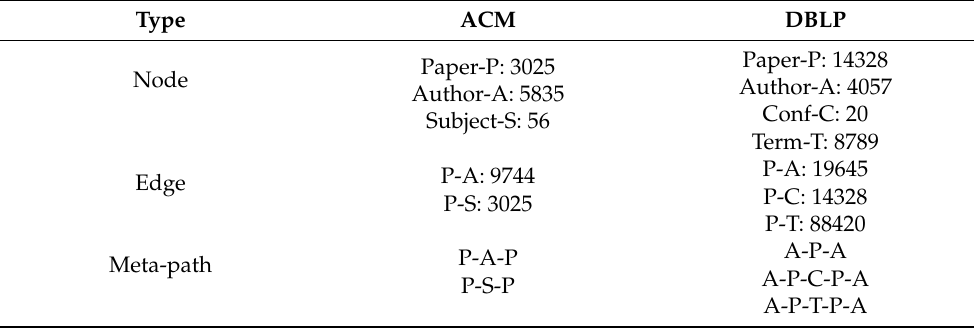
Table 1. Statistics of the